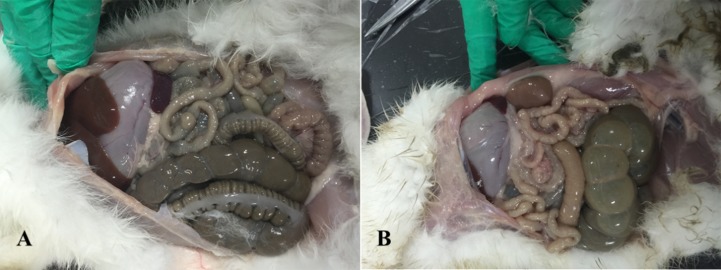
Intestinal changes in rabbits with diarrhea.(A) Healthy rabbits (n = 8). (B) Rabbits with diarrhea (n = 8), presenting with severe flatulence, wall thinning, and watery contents in the cecum and rectum.